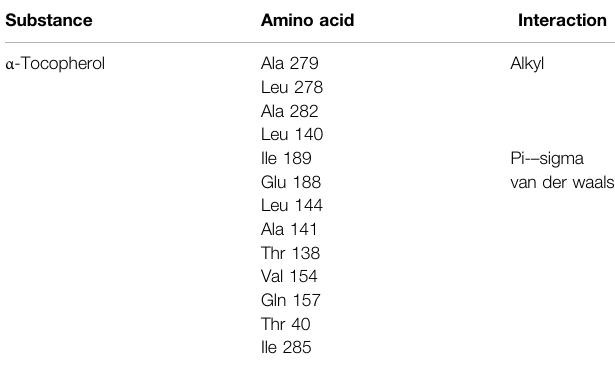
TABLE 7 | Amino acids that α -tocopherol interacts with as well as the type of interaction corresponding to this ligand. Substance Amino